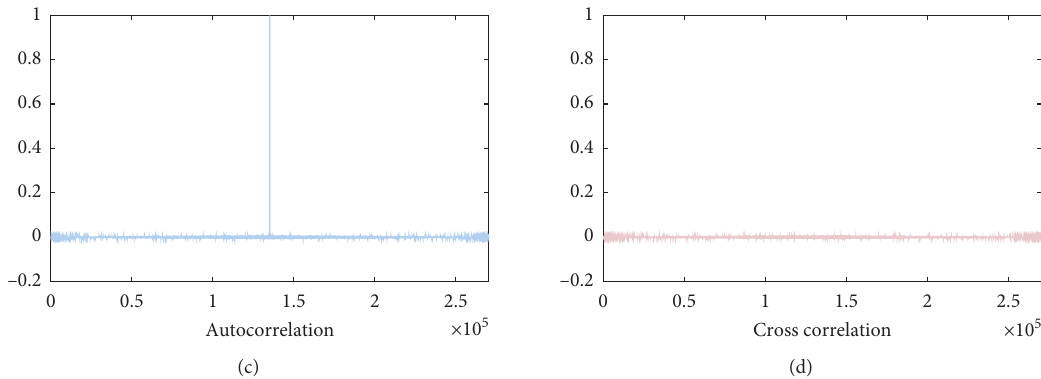
Figure 6: Correlation evaluation. (a) Results of Hamming distance. (b) Results of Pearson’s correlation coefficient. (c) Results of au- tocorrelation. (d) Results of cross correlation.